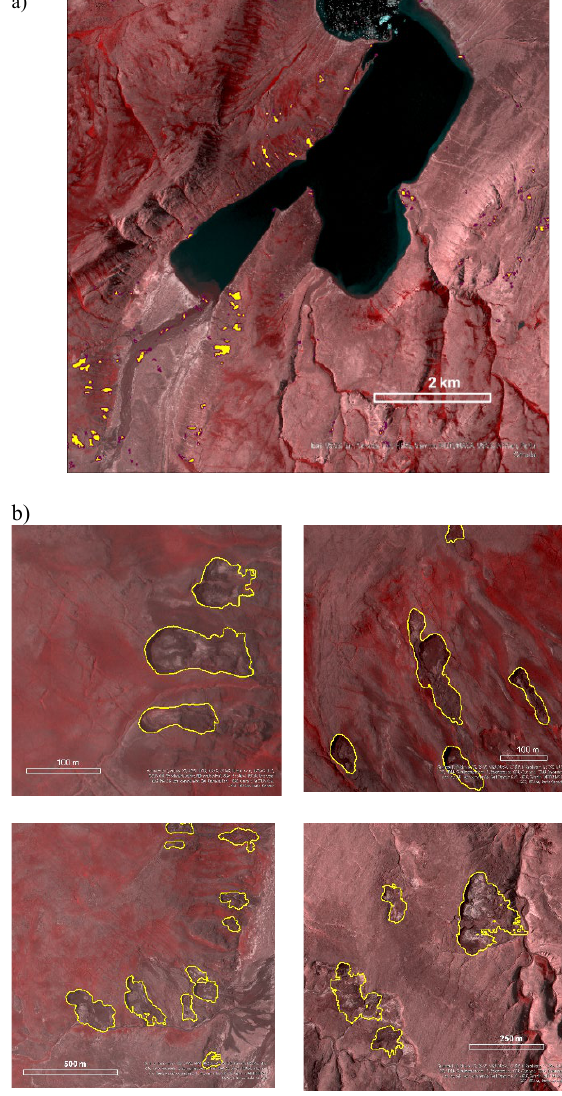
Figure 15. (a) The model application is Ellesmere Island. (b) Zoomed vies of the detections. (Imagery © 2016 DigitalGlobe,